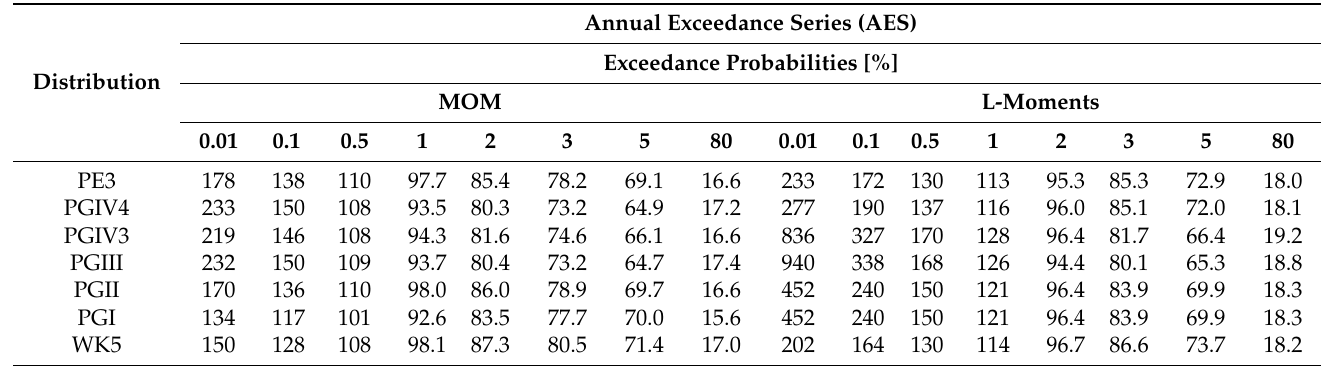
Table 8. Quantile results of the analyzed distributions for